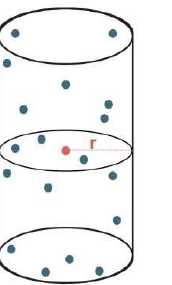
Figure 2. Cylinder neighbourhood selection definition; “r” is the radius of cylinder. The query point is in red colour, while the blue points are its neighbour